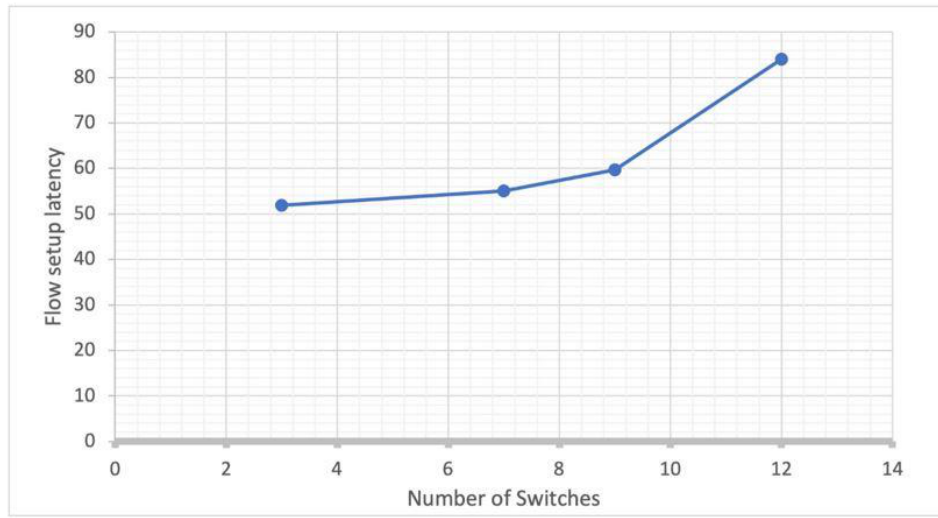
Figure 19. Graph showing flow setup latency.